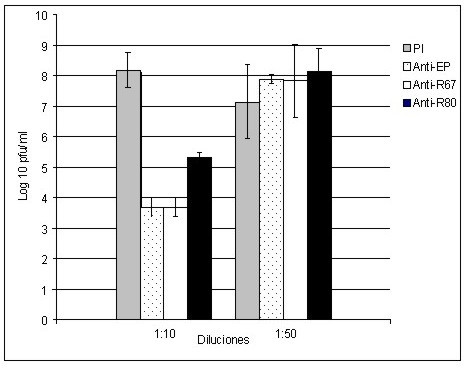
Inhibition of DENV2 infection by specific antibodies. C6/36 cell monolayers were incubated separately in the presence of pre-immune serum, anti-EP, anti-R67 or anti-R80 at 28°C for 60 min and then DENV serotype 2 was added (600 PFU/well) and incubated for 30 min at 4°C. After washing, fresh culture medium was added and the cells were incubated for 8 days. Pre-immune serum and antibodies were diluted 1:10 and 1:50. Viral titers in the supernatants were determined by viral plaque assay in LLC-MK2 cells. The experiments were repeated at least 3 times in quadruplicate.